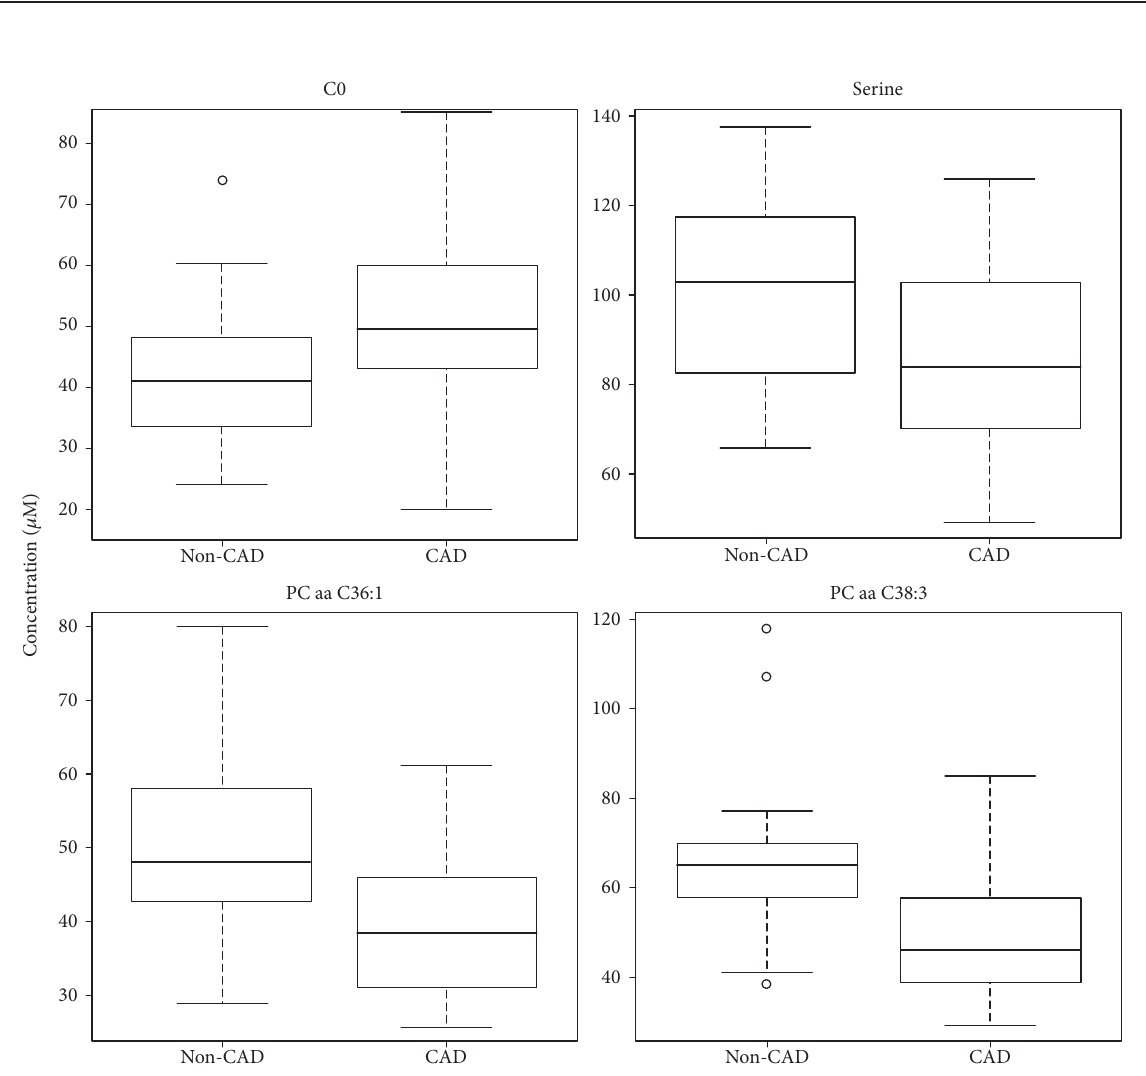
Figure 2: Boxplots of the four identi fi ed CAD-speci fi c metabolites. The continuous horizontal line is the median. The lower boundary of the box represents the 25th percentile, and the other boundary represents the 75th percentile. Whiskers above and below the box represent the 95th and 5th